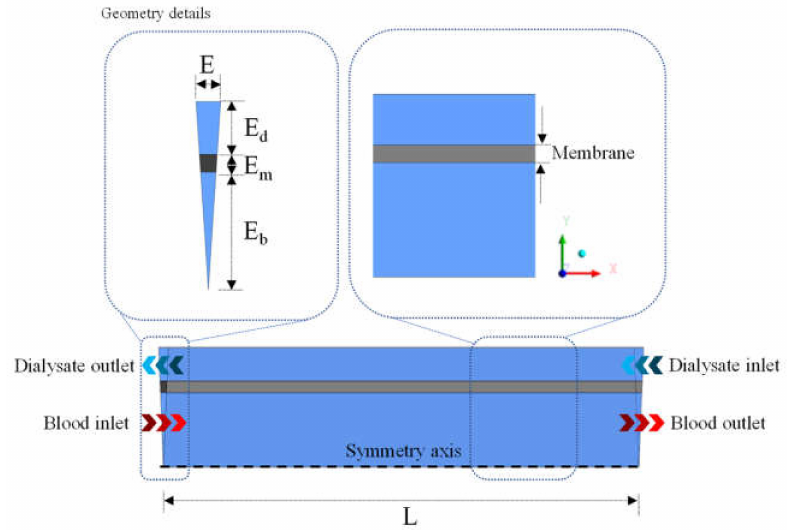
Figure 2. Geometric representation of the hollow fiber membrane.